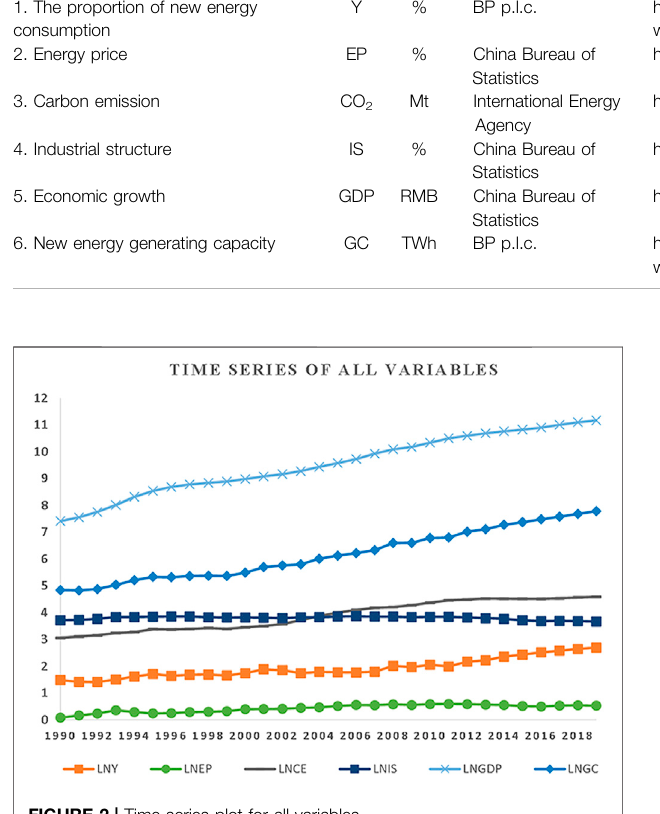
FIGURE 2 | Time series plot for all